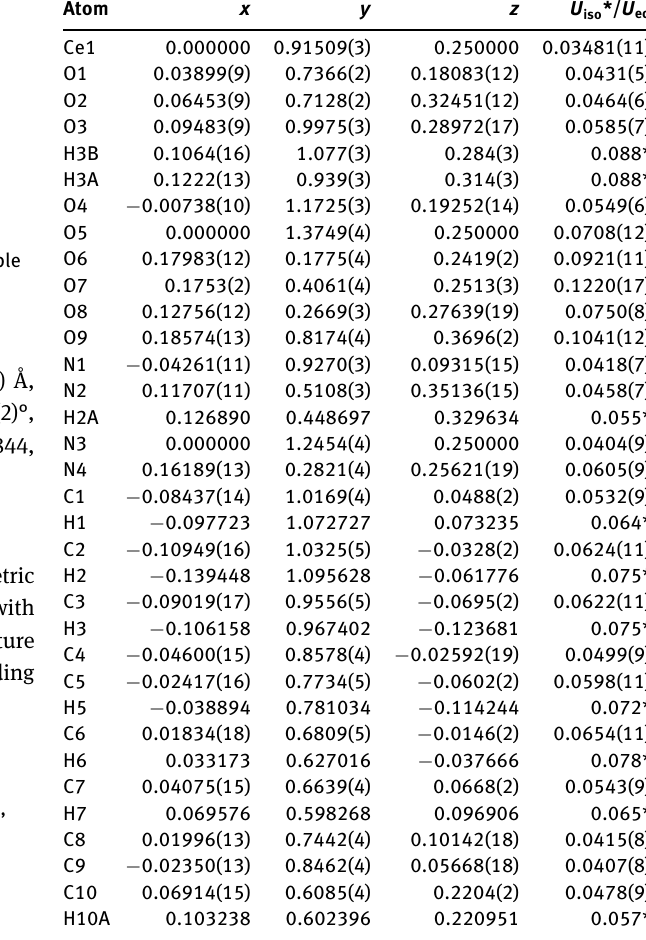
Table 2: Fractional atomic coordinates and isotropic or equivalent isotropic displacement parameters (Å 2